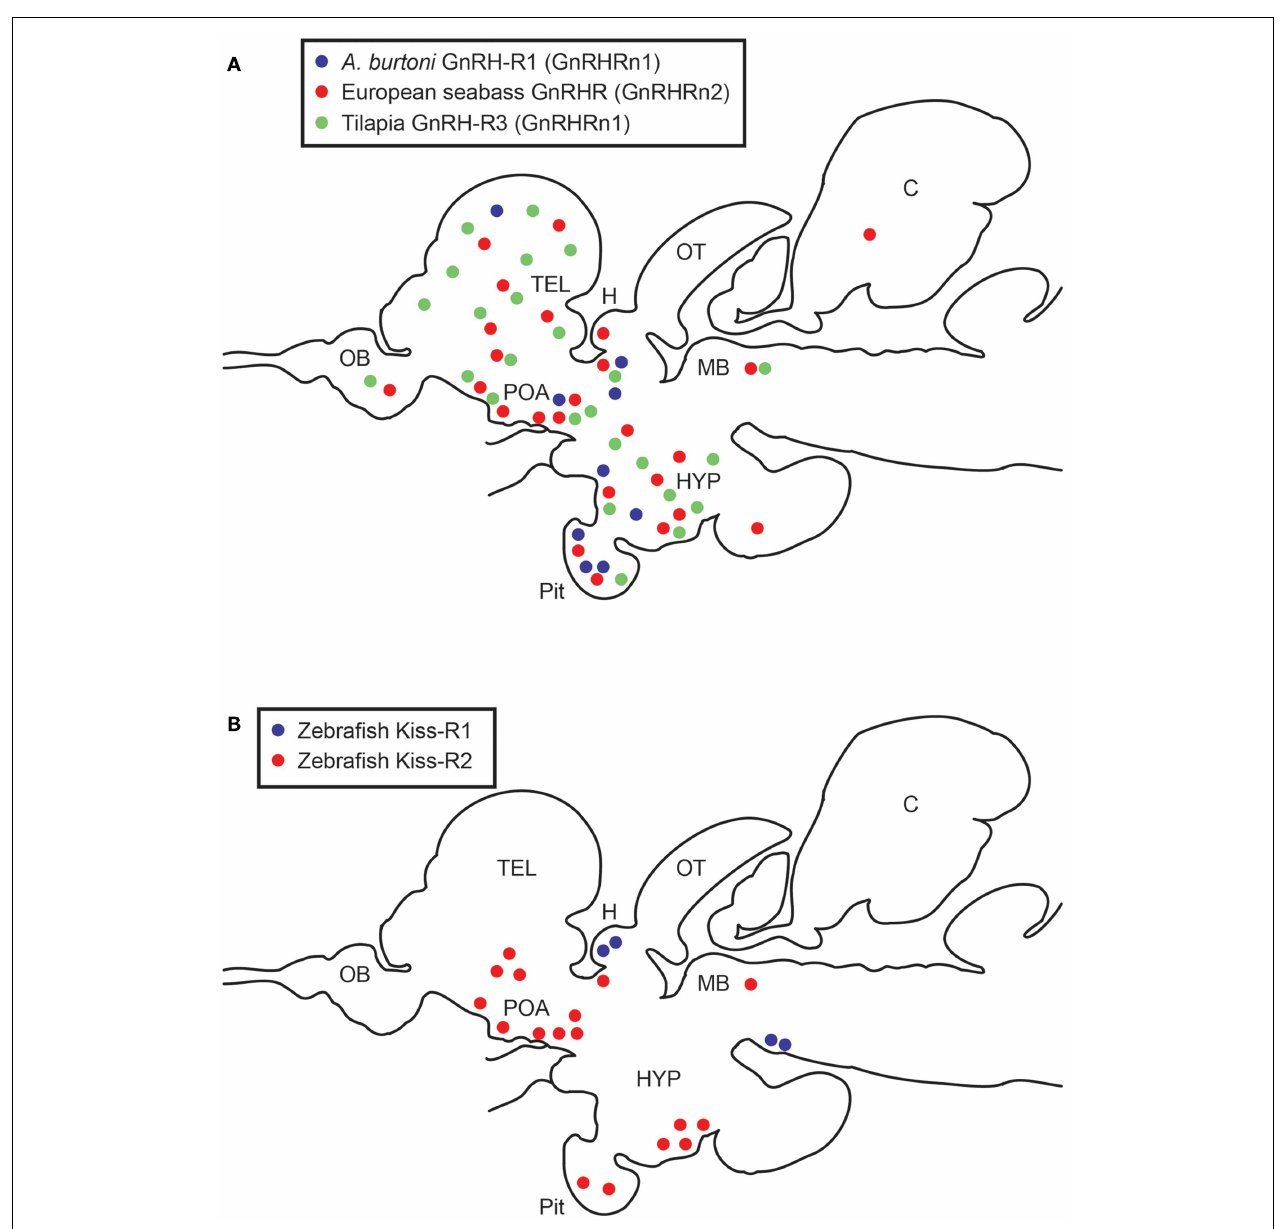
(GnRHRn2), red;Tilapia GnRHR3 (GnRHRn1), green circles. (B) Expression patterns of two Kiss-R types expressing cells in the zebrafish brain (Servili et al., 2011; Ogawa et al., 2012a). Kiss-R1 (GPR54b), blue; Kiss-R2 (GPR54a), red circles. OB, olfactory bulb;TEL, telencephalon; POA, preoptic area; H, habenula; OT, optic tectum; HYP, hypothalamus; C, cerebellum; pit, pituitary; MB,